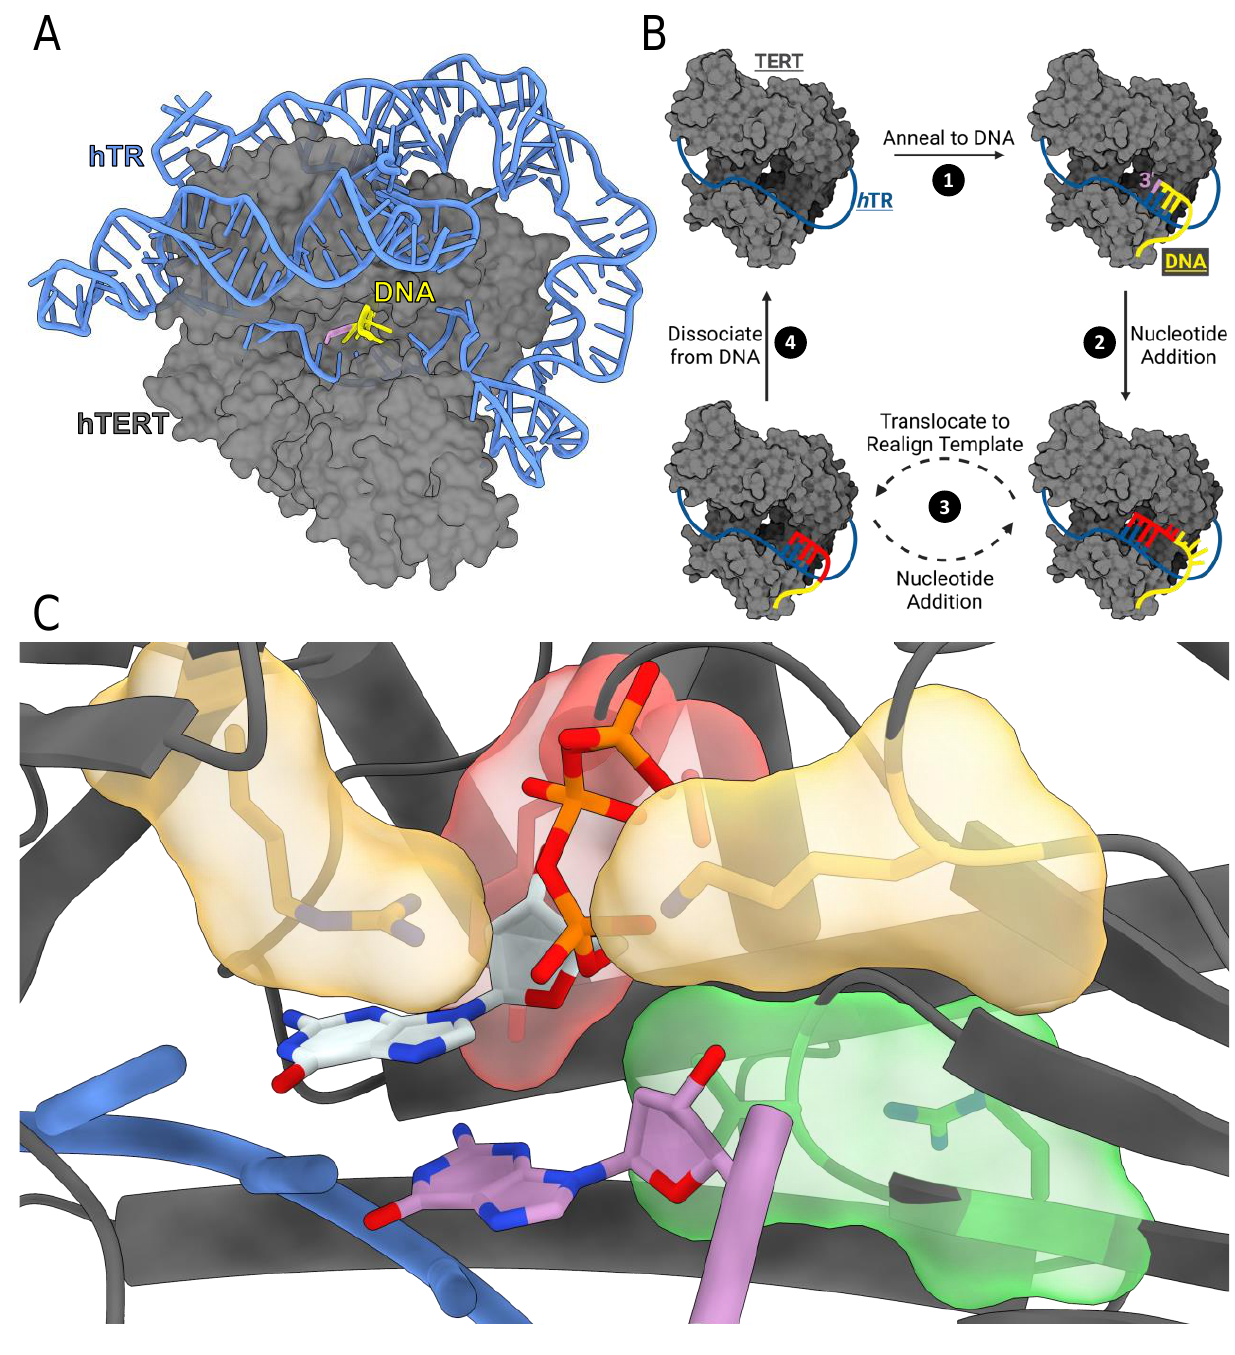
Figure 1. TERT structure and catalytic cycle. ( A ) hTERT/hTR (gray/blue) bound to DNA (yellow) with the DNA 3′ terminus indicating the active site (purple) (PDB: 7QXA). ( B ) Generalized diagram of telomerase’s catalytic cycle. ( C ) Closeup view of tcTERT active site with an incoming dGTP (PDB: 7KQN). TERT (gray), RNA template (blue), DNA 3′ -terminus (purple), R194 and K372 (yellow), R340 and V342 (green), A255 and Y256 (red), and dGTP (white). Heteroatoms are depicted with CPK coloring (key: nitrogen (blue), oxygen (red), and phosphate (orange)).